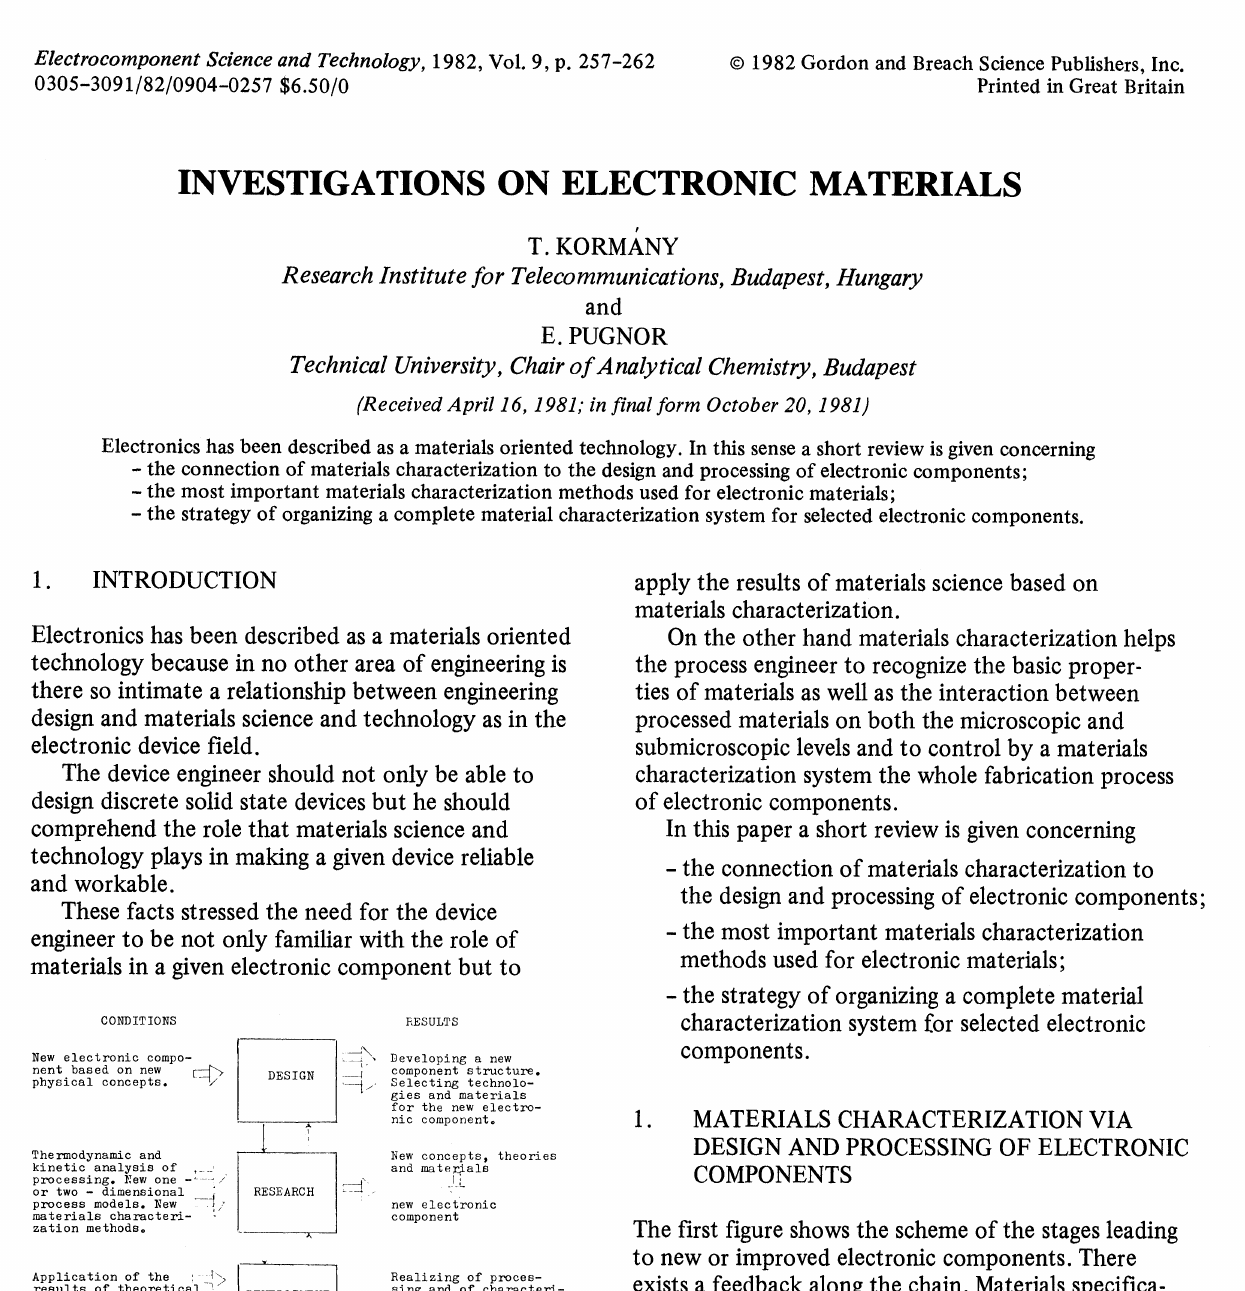
Generalized flow chart of electronic components